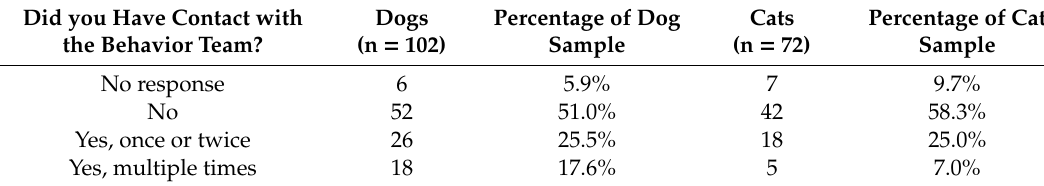
Table 8. Use of the Behavior Team resource.